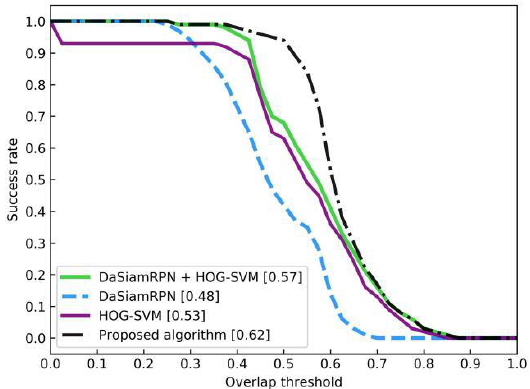
Figure 13. The success plots of Video Sequence II.